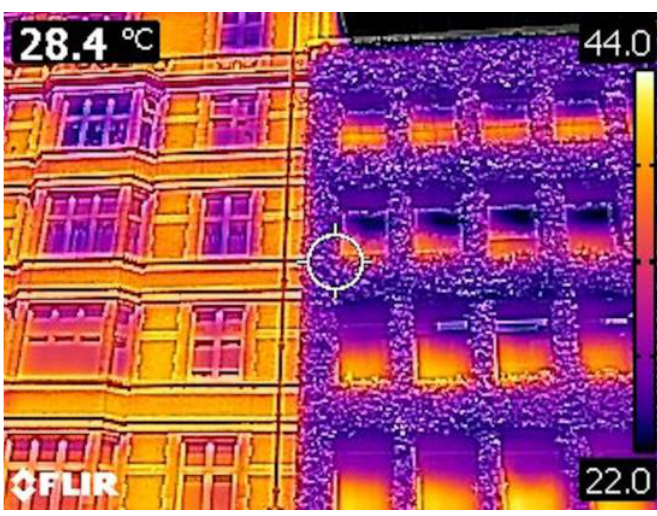
Thermal image showing the surface temperature of a green wall, central London Image: Gary